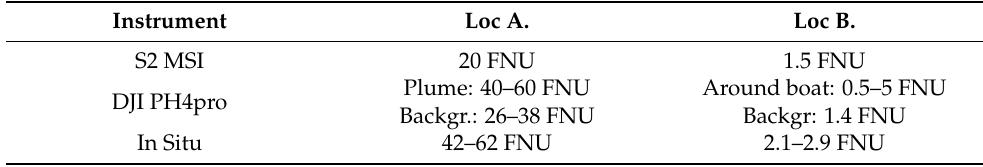
Figure 8. Sentinel-2 derived turbidity product on 13 April 2021 at 10:59 UTC. The two locations of drone flights are marked with A and B.